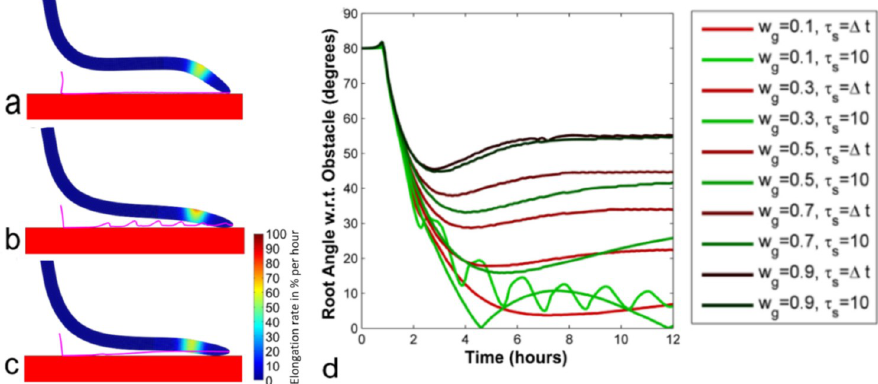
Fig 5. The interplay of gravity and touch responses. The sensitivity to gravitropic ( w g ) and thigmotropic ( w t ) signals was set at (a) 0.5 and 0.5, (b) 0.1 and 0.9, and (c) 0.9 and 0.1, respectively. Colors show the rate (%) of elongation per h. Magenta lines depict the trajectories of the tip. (d) Root angle w.r.t obstacle over time for roots with different w g and w t = 1 − w for τ = Δ t (immediate update of touch signal) and τ g s